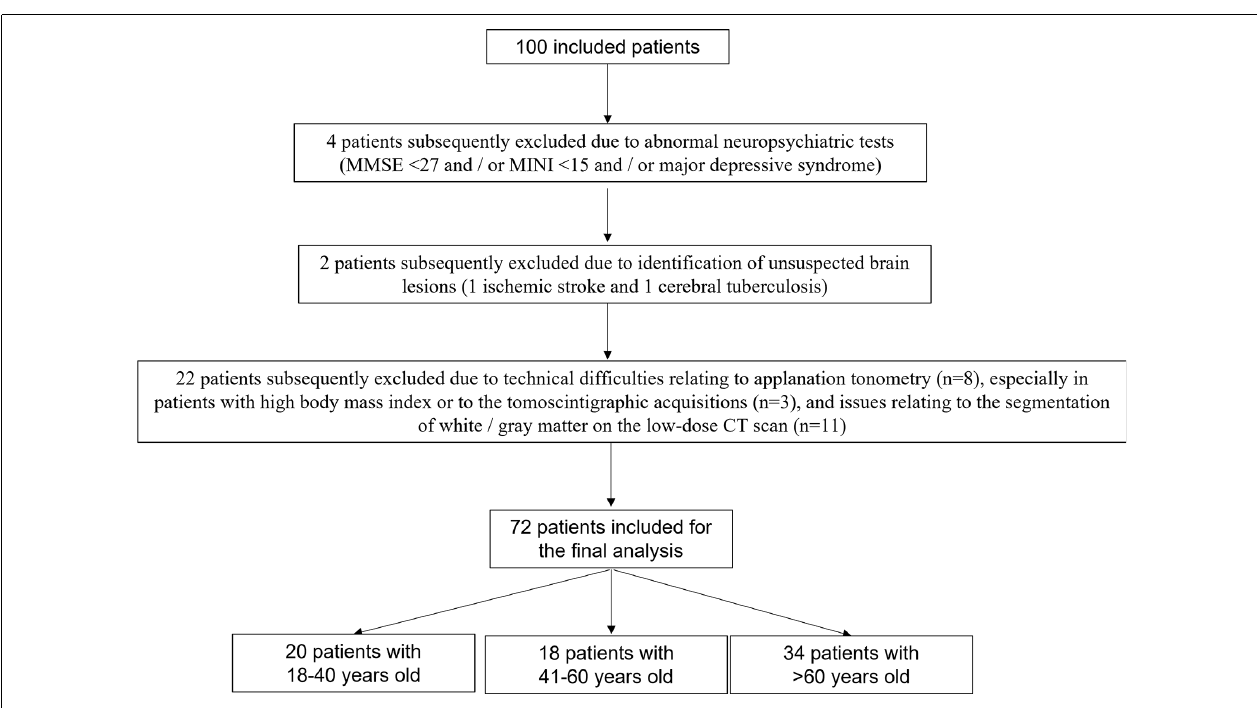
FIGURE 1 | Flowchart of patients included in the final analysis.